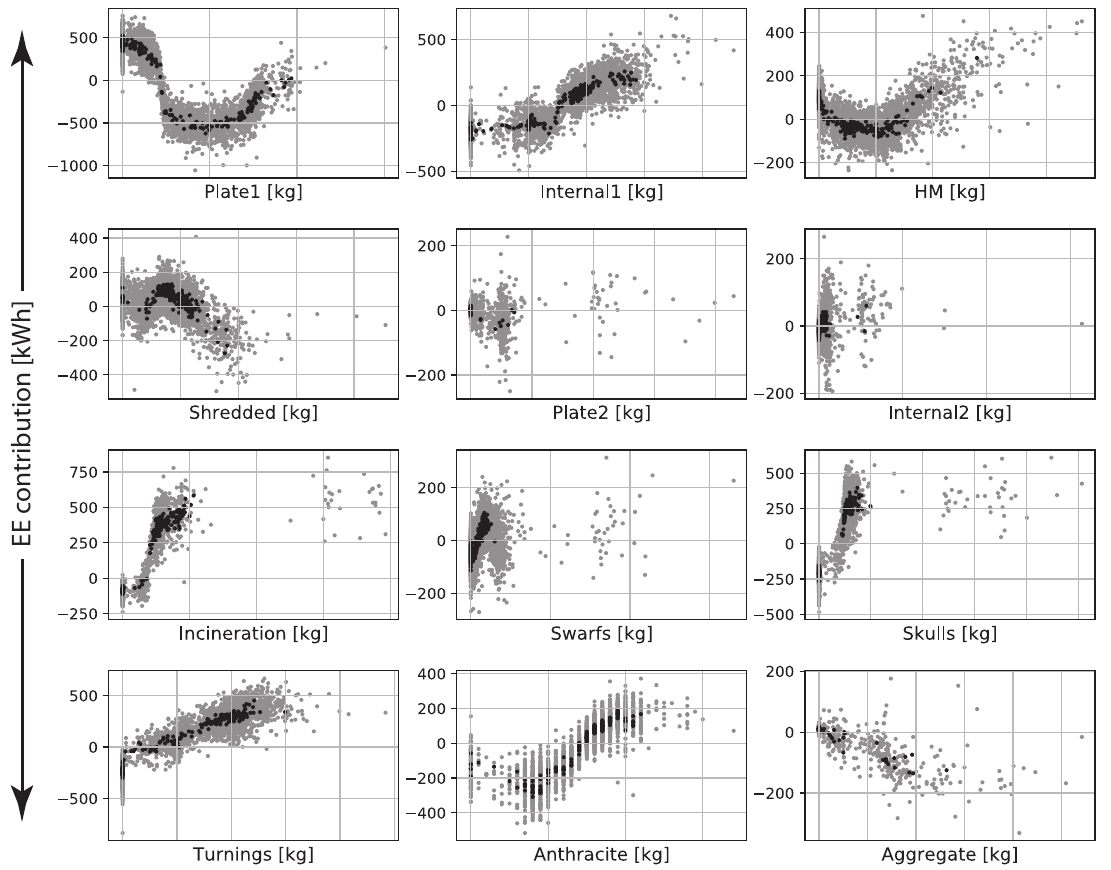
Figure 10. SHAP main interaction effects for the scrap categories for the selected model. The y-axes show the main interaction effect on EE while the x-axes show the amount of each charged scrap category. The values on the x-axes has been omitted due to proprietary reasons. The grey dots represent values from the training data and the black dots represent values from the test